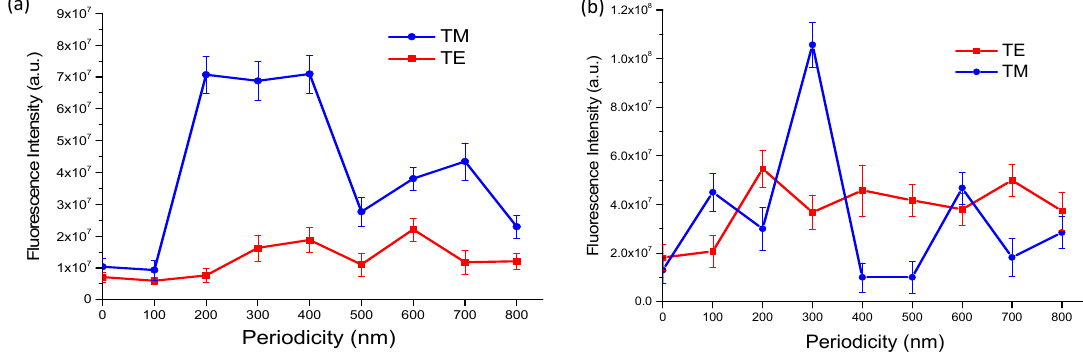
Figure 5. Periodicity and polarization dependence of the fluorescence intensities for ( a ) nonlift-off and ( b ) lift-off nanogratings. The blue circles and lines are for TM-polarized excitation and the red squares and lines are for TE-polarized excitation.